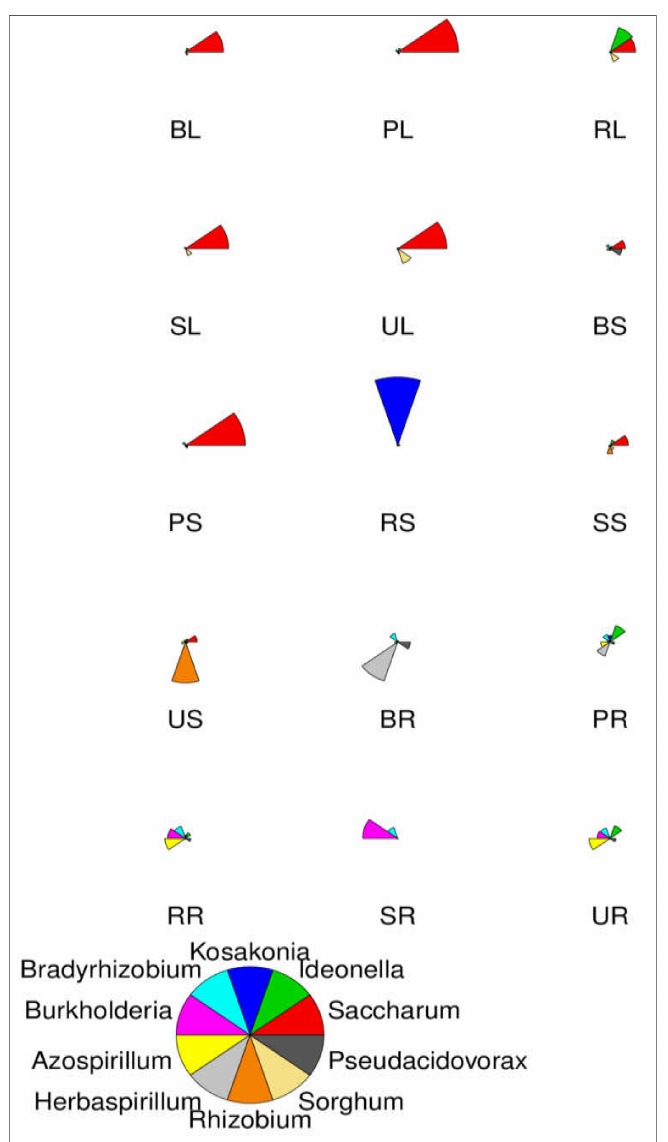
Figure 4. Star map showing species abundance of the top 10 most abundant genera. The fan shape in each star chart represents a species, which is distinguished by different colors. The radius of the fan is used to represent the relative abundance of the species. The longer the radius of the fan, the higher the abundance, and the lower the